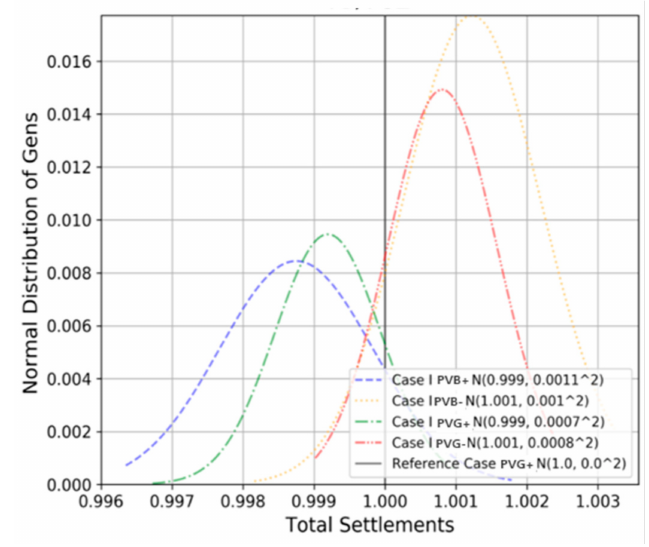
Figure 6. Distribution of PVs revenue in each group under Case I.